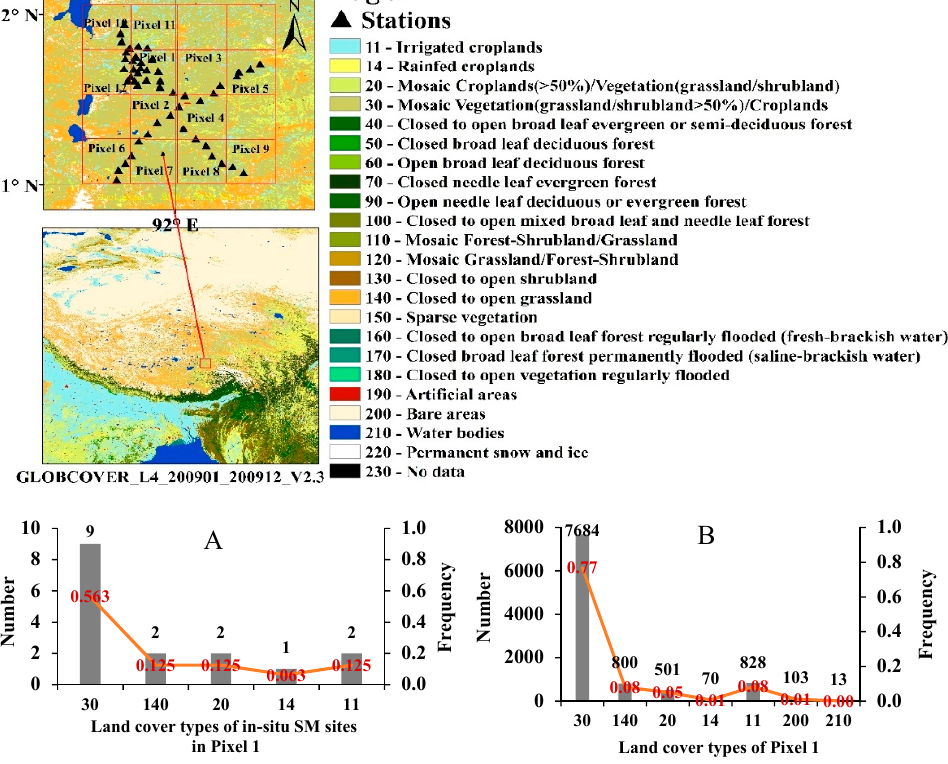
Figure 2. Location and land cover types of the study area and in-situ sites in Naqu on the Tibetan Plateau. A : histogram of land cover types at the locations of in-situ SM measurements in Pixel 1; B : histogram of land cover types of Pixel 1 with 25 km × 25 km; land cover based on the GLOBCOVER 2009 map at 300 m × 300 m spatial resolution.